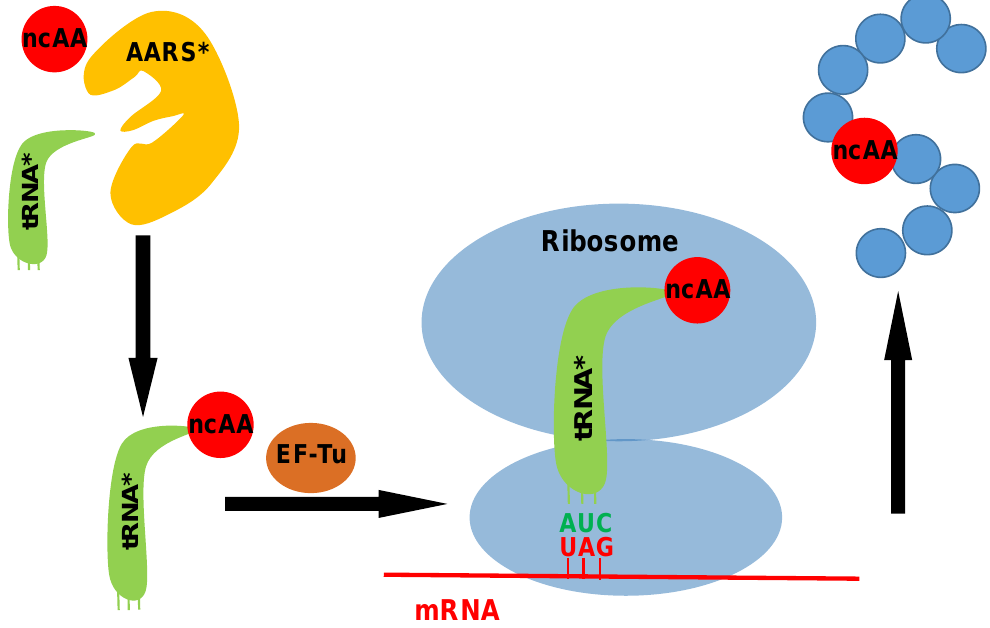
Figure 1. A scheme for the genetic code expansion strategy. The introduced orthogonal aminoacyl-tRNA synthetase (AARS) charges its cognate tRNA with one ncAA. Then the ncAA-charged tRNA is brought to the ribosome by EF-Tu. The introduced tRNA with a designed anticodon can read the corresponding codon in the mRNA (UAG is probably the most reassigned codon used for co-translational incorporation of posttranslational modifications (PTMs).), then direct the incorporation of ncAA into the specific site of the target protein. AARS*: introduced aminoacyl-tRNA synthetase; tRNA*: introduced tRNA; ncAA: noncanonical amino acid.